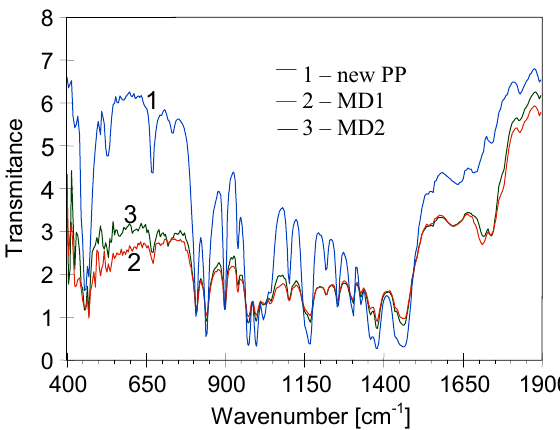
Figure 14. Comparison of FTIR spectra recorded for new Accurel PP S6/2 membrane and for membrane samples removed from MD1 and MD2 modules.